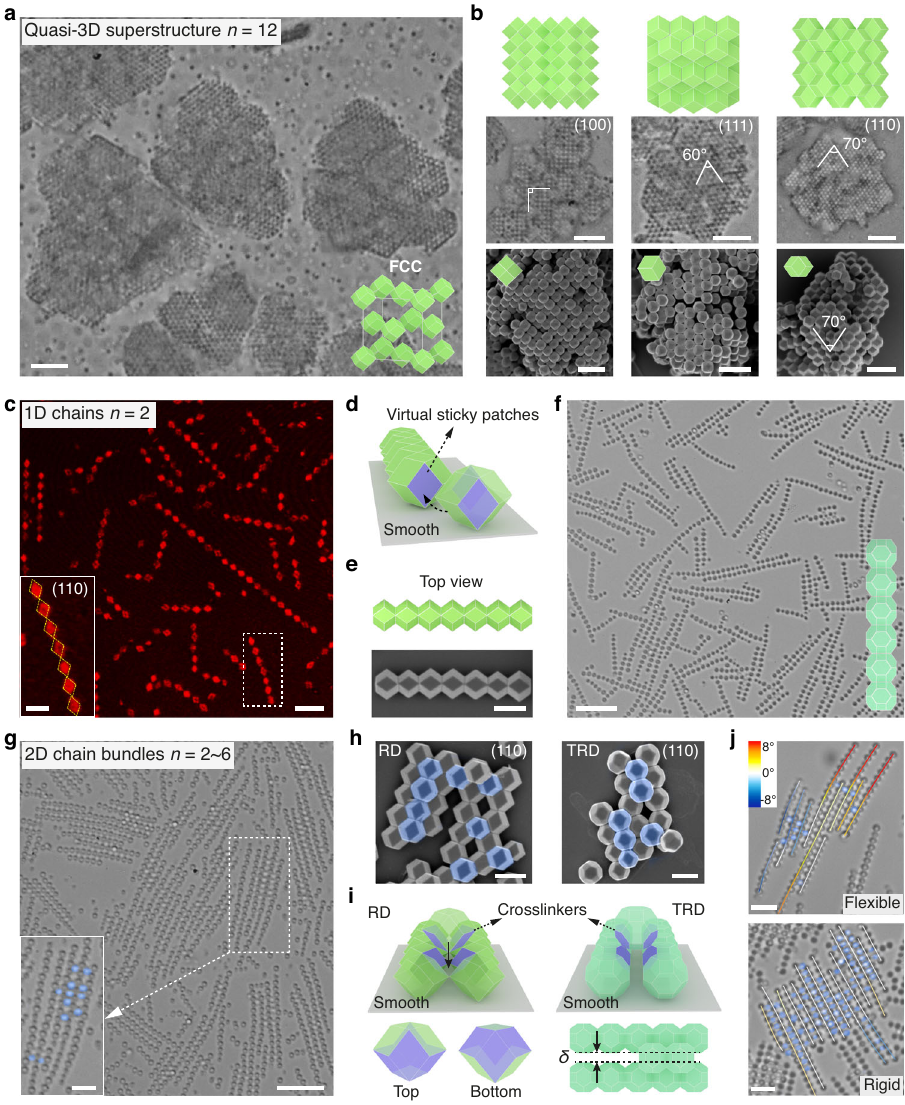
Fig. 2 Self-assembly of ZIF-8 particles and dimension control. a , b Quasi-3D superstructures assembled from 0.9- µ m ZIF-8 RD particles on a rough substrate. For each particle, the coordination number n = 12. Large-view optical microscope image of the assembled crystals with a face-centered cubic structure (FCC) is shown in ( a ). Cartoons, zoomed-in optical images and SEMs in ( b ) show (100)-, (111)-, and (110)-oriented colloidal crystals; the axial angles are labeled. c – f 1D chains ( n = 2) by assembling ZIF-8 RD ( c – e ) or truncated rhombic dodecahedra (TRD) ( f ) particles on a smooth substrate. Re fl ected-light confocal microscopy image in ( c ) reveals the well-arrayed rhombic faces (inset, orange dashed lines) within the RD chain. Cartoon in ( d ) illustrates that the particles stand on the substrate by their (110) faces and contact with one another by virtual patches (purple) to form a chain. Cartoon and SEM image in ( e ) show the top view of a colloidal chain. f Cartoon and bright- fi eld optical image of chains assembled by TRD particles. g – j 2D chain bundles ( n = 2~6). Optical ( g ) and SEM images ( h ) show the structure of ZIF-8 chain bundles and highlight the crosslinker particles (in blue). Cartoons in ( i ) illustrate the binding and the corresponding particle facets (purple) between the chains (at bottom layer) and the crosslinkers (at upper layer). A gap with a width of δ is observed between the bridged chains of TRD particles. Optical images in ( j ) show the fl exible and rigid chain bundles according to the number density of crosslinkers. Color of chain segment denotes the deviation in angles from straight chain (white line). Scale bars: 5 µ m for microscope images in ( a , b ), 2 μ m for SEMs in ( b ), 5 and 2 µ m (inset) for ( c ), 1 µ m for ( e , h ), 10 µ m for ( f ), 10 and 5 µ m (inset) for ( g ), and 3 µ m for ( j